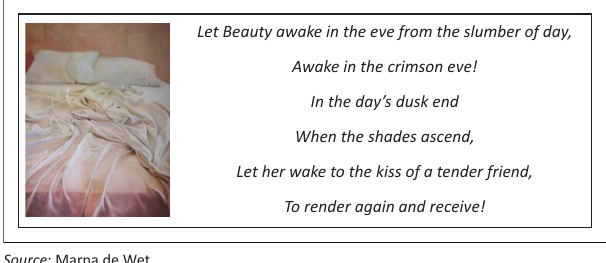
FIGURE 5: Let Beauty Awake: ‘The